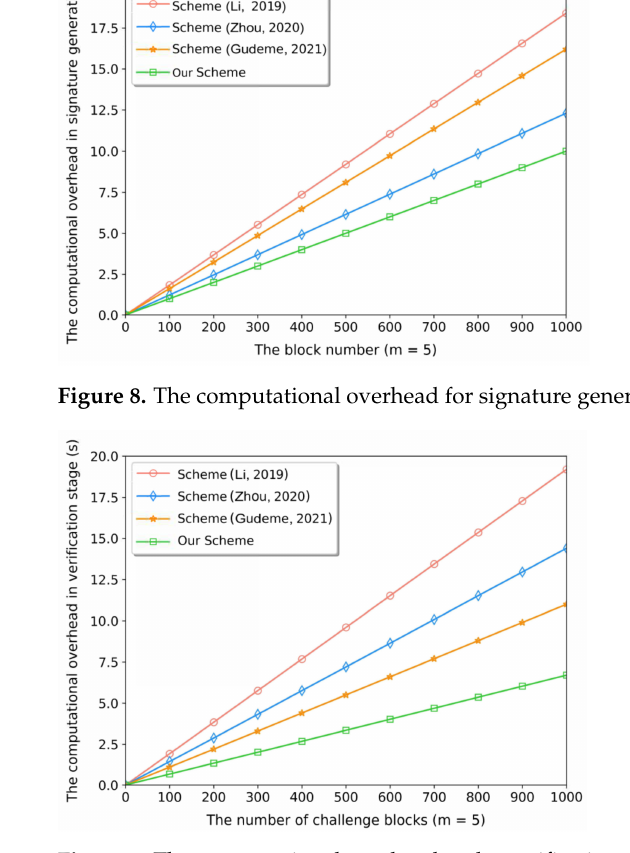
Figure 9. The computational overhead at the verification stage [21,24,35].